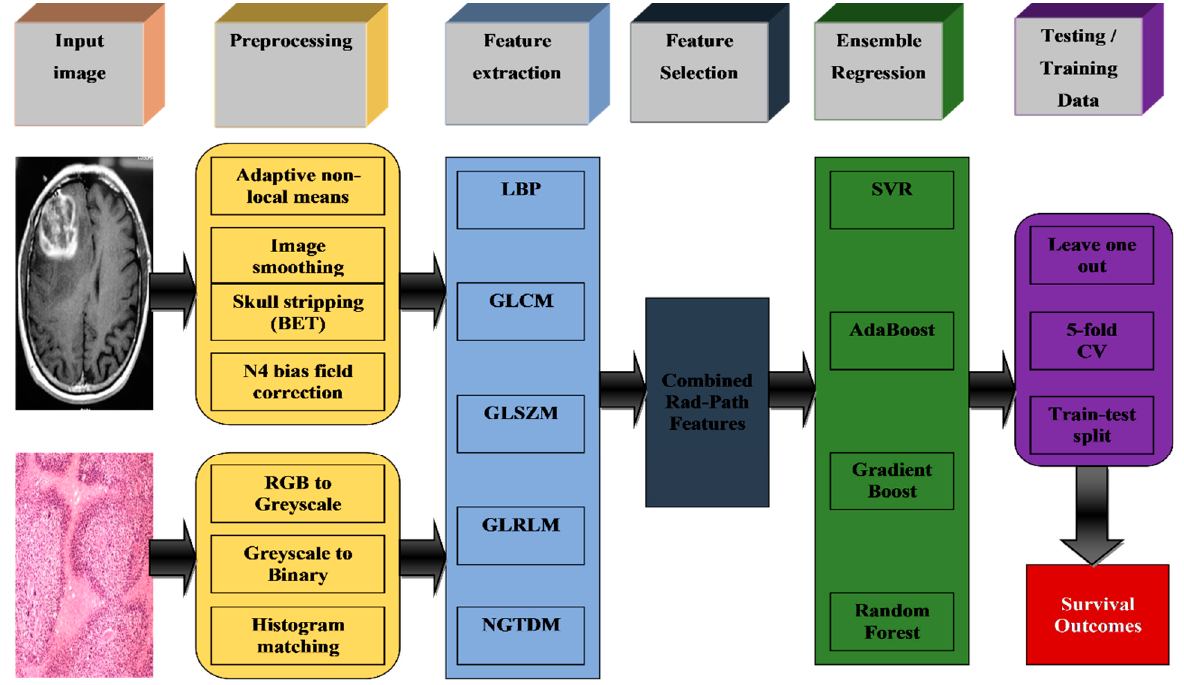
Figure 1. Schematic diagram of proposed survival prediction method, employing state-of-the-art feature extraction methods and an ensemble of machine learning regression methods.